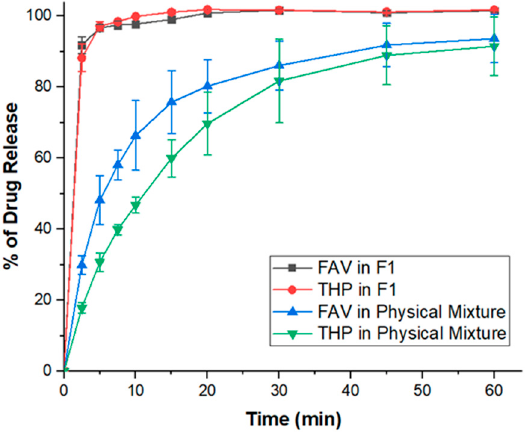
Figure 10. In vitro dissolution profile of FAV and THP in the optimized spray-dried cocrystal formulation F1 with aerodynamic diameters <5 µ m ( n = 3).